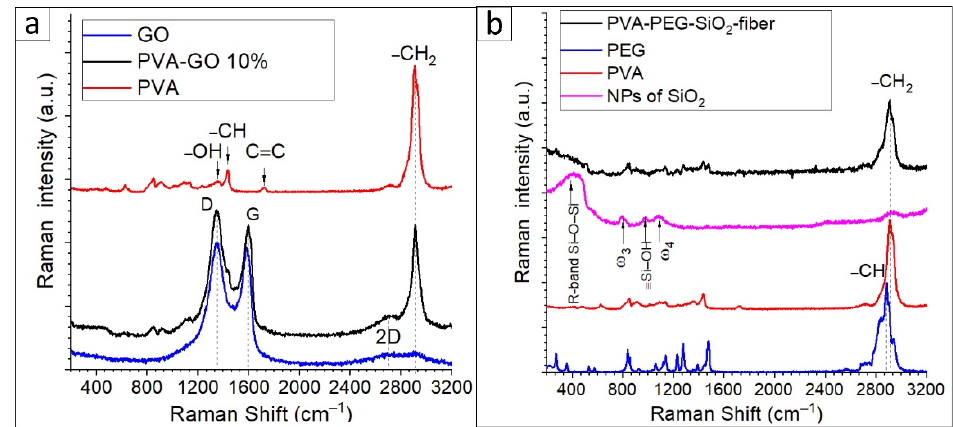
Figure 8. Raman spectra of samples: ( a ) GO and PVA–GO shell and PVA fiber mat; ( b ) PVA–PEG–SiO 2 core fiber and the components (NPs of silica, PEG, and PVA).